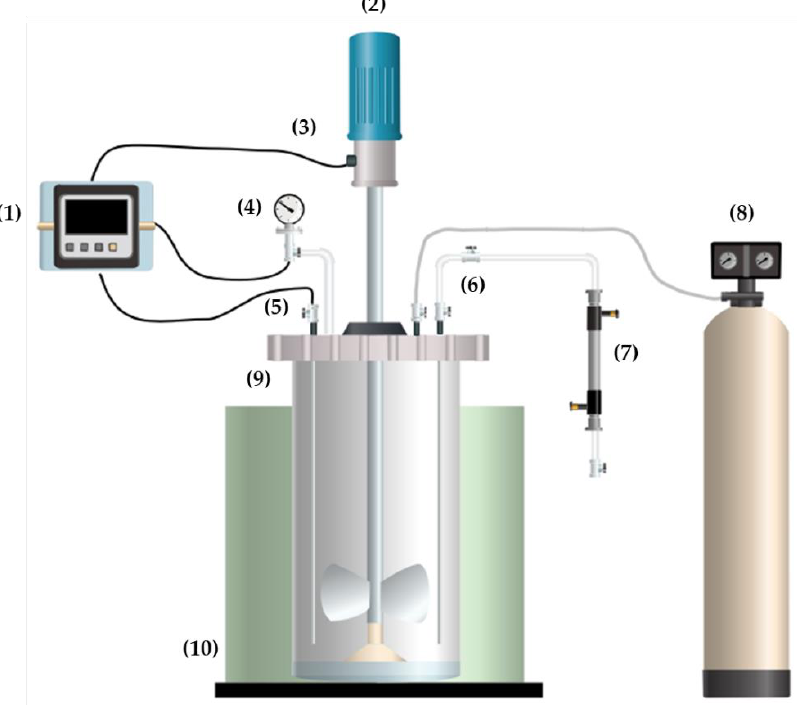
Figure 2. Schematic of the continuous stirred-tank reactor used for the one-pot conversion of lactose permeate: (1) data logger, (2) stirrer, (3) tachometer, (4) pressure gauge, (5) thermocouple, (6) sampling port, (7) cooling system, (8) nitrogen cylinder, (9) stainless-steel reactor, (10) electrical heater.